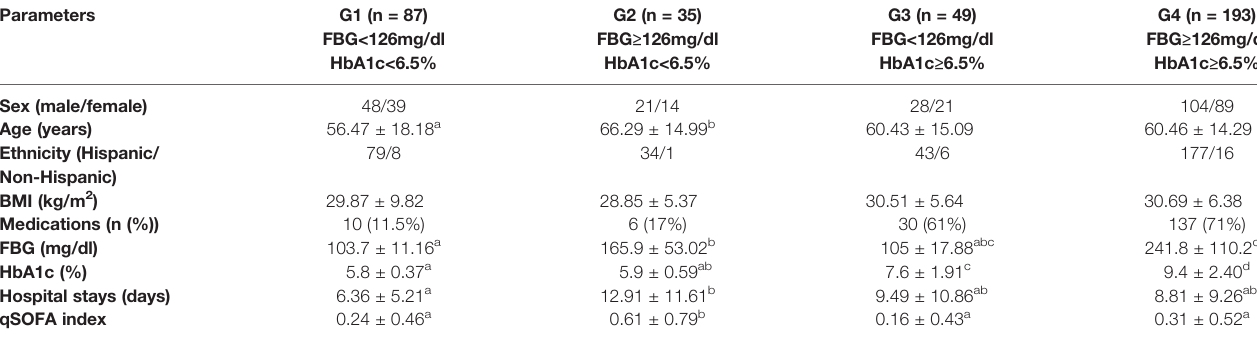
TABLE 3 | Characteristics of patients categorized into 4 groups based on their fasting blood glucose and glycated hemoglobin level. Parameters